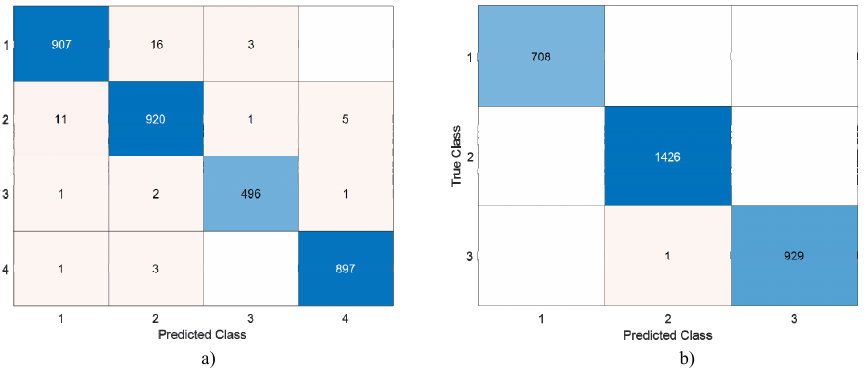
Figure 9. Accuracy graph obtained using SVM for various split ratios. 124,800 features were obtained from DenseNet201 with the help of 28 × 28 patches. These features are selected with the help of INCA. With INCA, 231 features were selected for Dataset I, and 220 features were selected for Dataset II. The selected features were classified by running 100 times with SVM 10 fold CV. Confusion matrices of the highest accuracy achieved are shown in Figure 10.